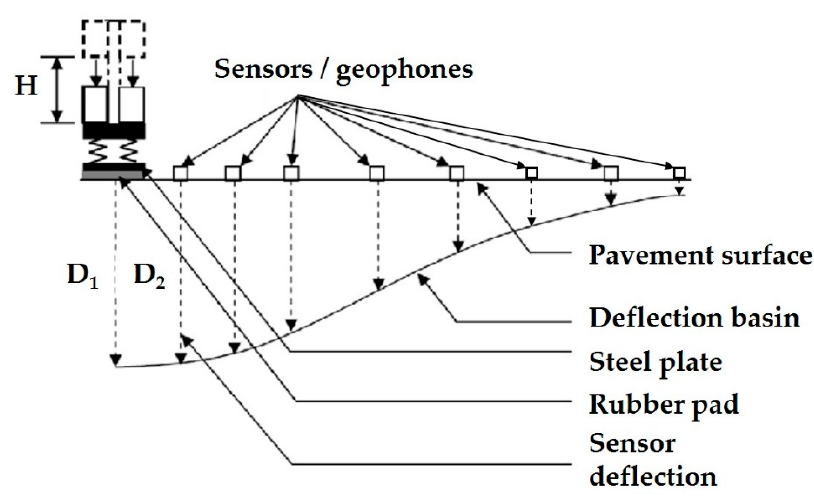
Figure 3. Operation principles of FWD (not to scale).